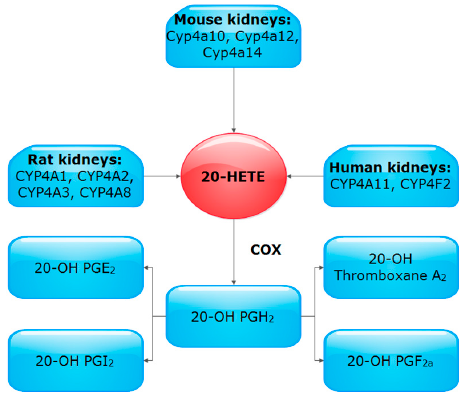
Figure 3. Enzymes responsible for 20-HETE formation and metabolism in different species. 99